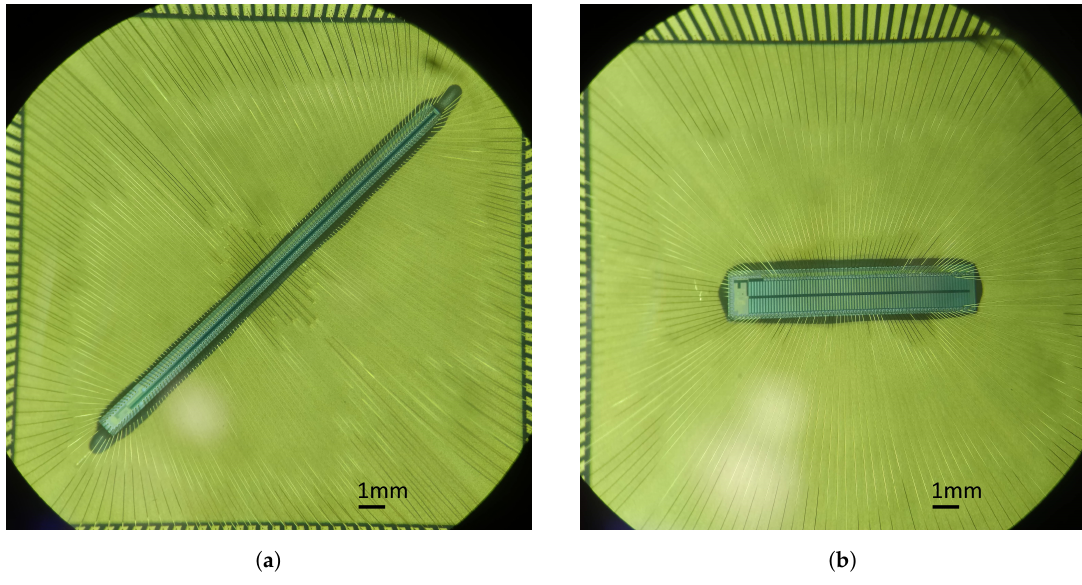
Figure 9. The two realized SOMBRA versions. ( a ) SOMBRA-LV10. ( b )